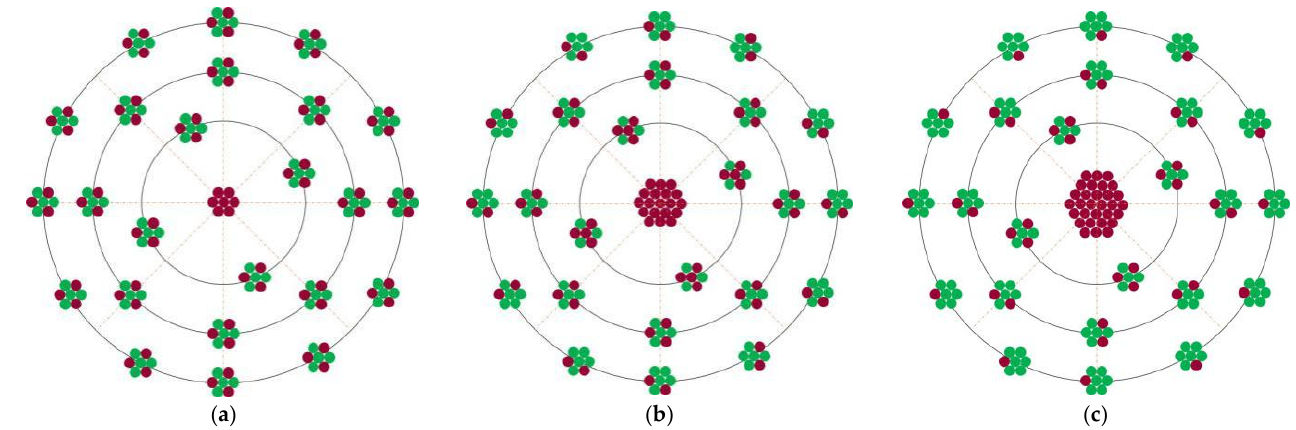
Figure 4. Schematic diagram of the formation of Zr-enriched halo structure in Mg–Zr alloy during solidification process ( a ) initial stage ( b ) intermediate stage ( c ) final stage.